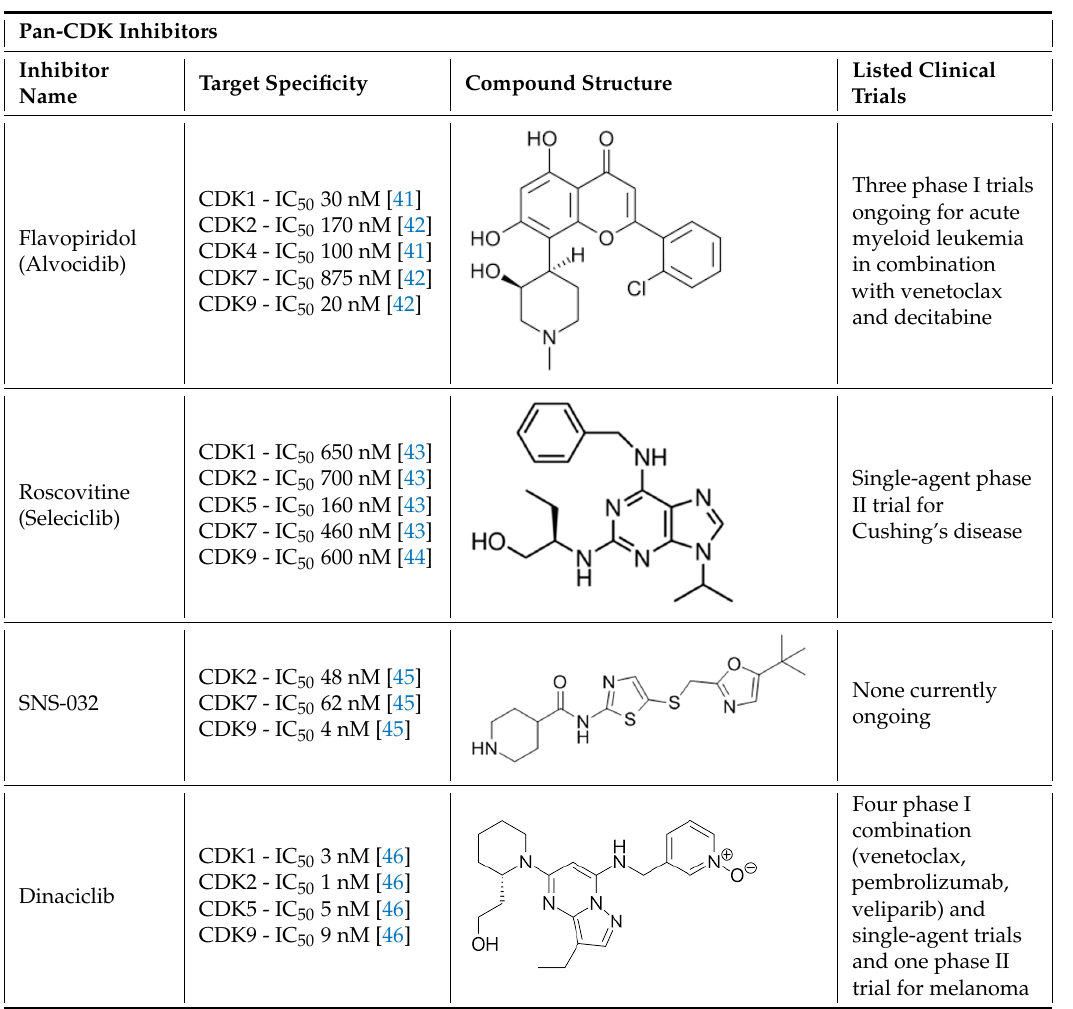
Table 1. List of transcriptional inhibitors with target specificities, chemical structures, and current clinical trials. Available target specificities are listed as described in the current literature. Current clinical trials are those presently listed on clinicaltrials.gov with “recruiting”, “enrolling by invitation”, and “active, not recruiting” statuses.